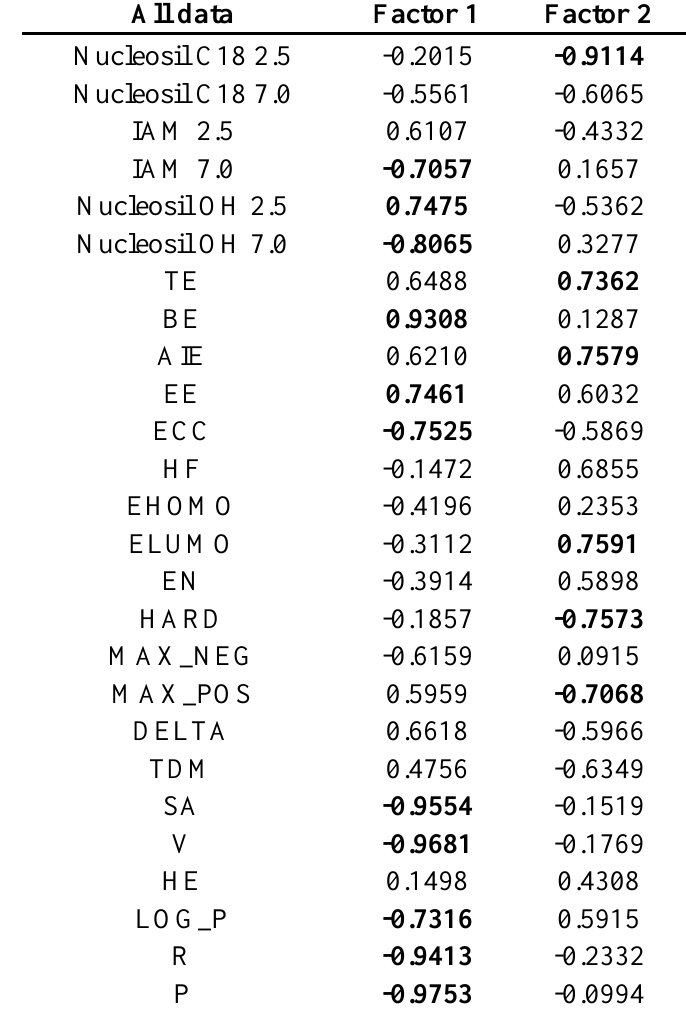
Table 6. Principal component analysis loadings by all